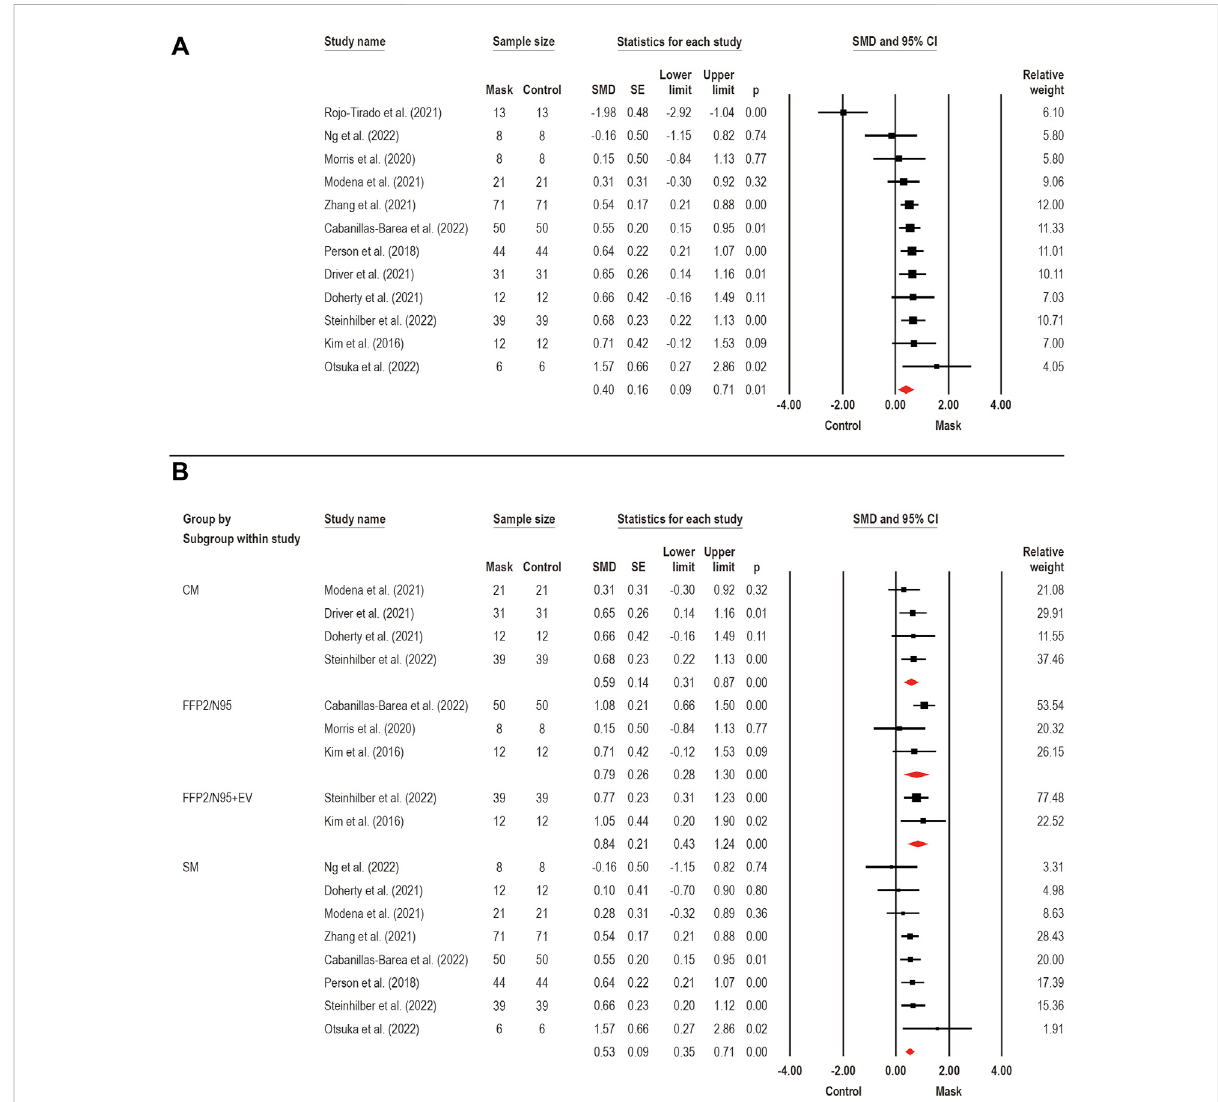
FIGURE 3 Acute effects of face mask vs. control (unmasked condition) on dyspnea. Forest plots with pooled standardized mean difference (SMD), standard errors (SE), and 95% con fi dence intervals (CI) are displayed: (A) analysis of face mask wearing effects on dyspnea (SMD: 0.40; 95% CI 0.09 – 0.71; p = 0.01; I 2 = 68%); (B) subgroup analysis of face mask wearing effects by face mask type [CM: clothing mask (SMD: 0.59; 95% CI 0.31 – 0.87; p < 0.001;I 2 =0%);SM:surgicalmask(SMD:0.53;95%CI0.35 – 0.71; p < 0.001;I 2 =0%);FFP2/N95:facepiecerespiratortype2(SMD: 0.79;95%CI 0.28 – 1.30; p < 0.001;I 2 =37%);andFFP2/N95 +EV:facepiece respirator type2withexhalationvalve(SMD: 0.84;95%CI 0.43 – 1.24; p < 0.001; I 2 =